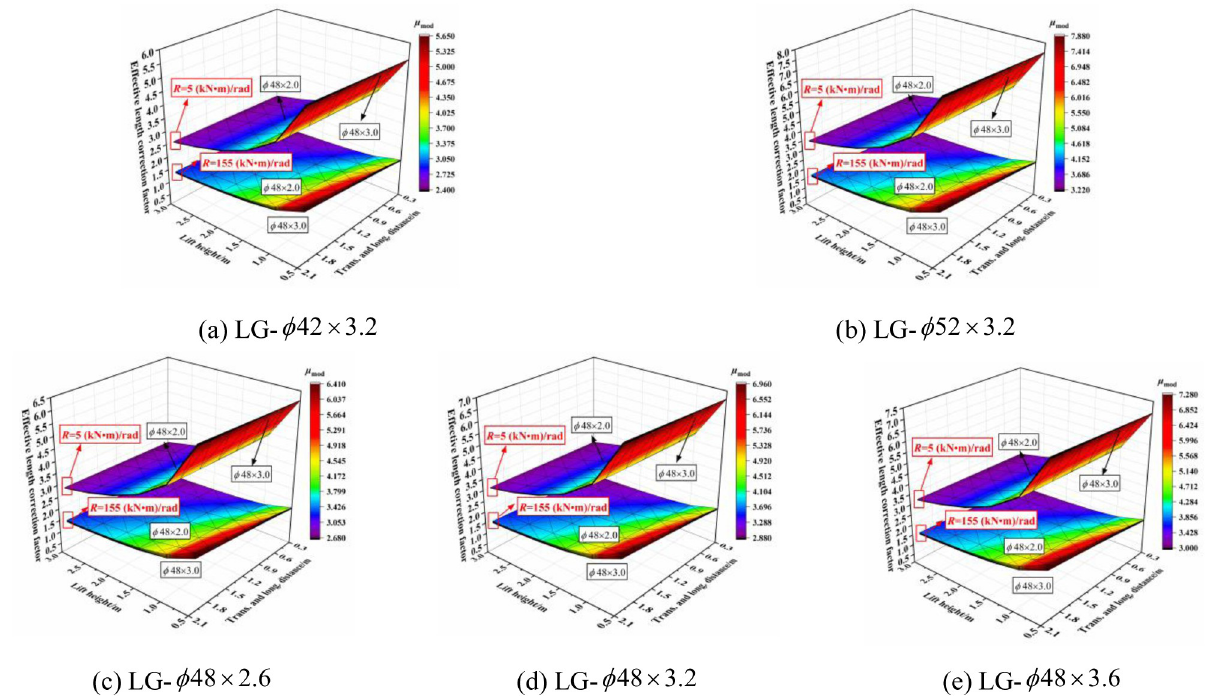
Fig 23. Three-dimensional diagrams of the influence of the wall thickness size of the horizontal bar section on the effective length correction factor. (a) LG- ϕ 42 × 3.2. (b) LG- ϕ 52 × 3.2. (c) LG- ϕ 48 × 2.6. (d) LG- ϕ 48 × 3.2. (e) LG- ϕ 48 × 3.6.